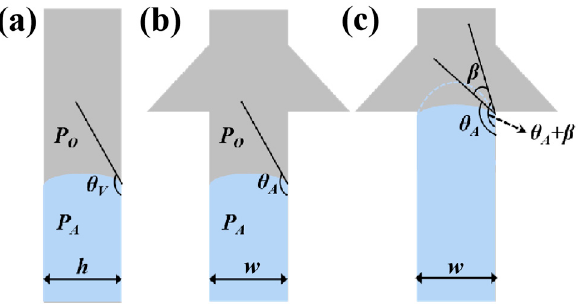
Figure 3. Schematic diagrams of ( a ) side view and ( b ) front view of the valves when liquid is stationary in the microchannel. ( c ) Schematic diagram of the valves when liquid flows into the inlet of CBV#1, with the contact angle increasing from θ A to θ A+ β .